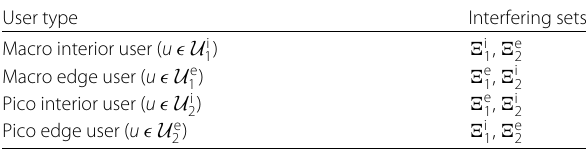
Table 1 The Interfering sets of a typical user User type Interfering